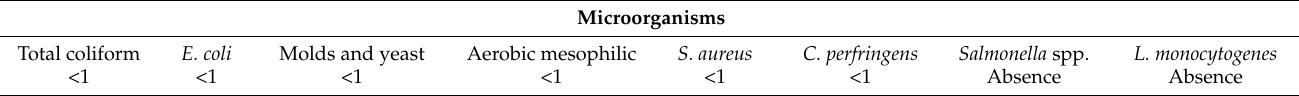
Table 3. Microbiological quality test of the chitosan extraction process.